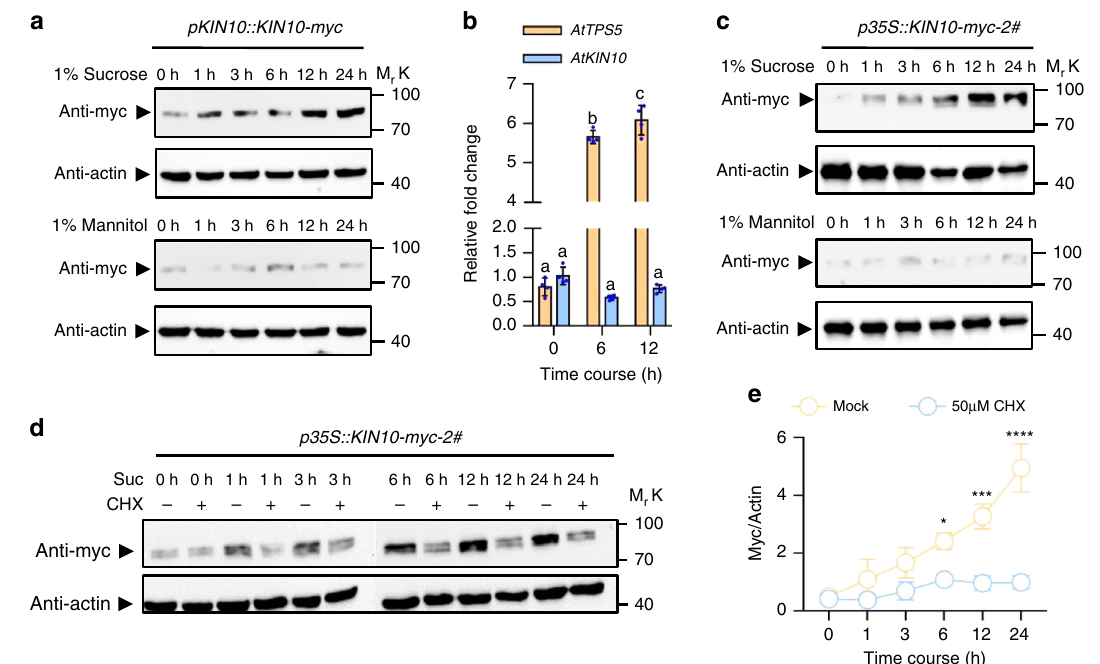
Fig. 3 Sucrose induces the KIN10 protein accumulation. a Immunoblot analysis of the protein levels of KIN10-myc in pKIN10::KIN10-myc transgenic plants using anti-myc antibody. Seedlings of pKIN10::KIN10-myc transgenic plants were grown in sugar free ½ MS liquid medium for 3 days and then treated with 1% sucrose or 1% mannitol for different time periods. b Quantitative RT-PCR analysis the expression of KIN10 in response to sucrose. Wild-type seedlings were grown in sugar free 1/2 MS liquid medium for 3 days then treated with 1% sucrose for different times. PP2A gene was analyzed as an internal control. Error bars represent standard deviation of four independent experiments. Different letters above the bars indicated statistically signi fi cant differences between the samples (ANOVA analysis followed by Uncorrected Fisher ’ s LSD multiple comparisons test, p < 0.05). c Sucrose induces KIN10 protein accumulation in p35S::KIN10-myc transgenic plants. Seedlings of p35S::KIN10-myc transgenic plants were grown in sugar free ½ MS liquid medium for 3 days and then treated with 1% sucrose or 1% mannitol for different time periods. d Immunoblot analysis the effects of cycloheximide (CHX) on the Sucrose-induced the KIN10 protein accumulation. Seedlings of p35S::KIN10-myc transgenic plants were grown in sugar free ½ MS liquid medium for 3 days and then treated with or without 1% sucrose and 50 μ M CHX for different time periods. e Quanti fi cation analysis of CHX effect on sucrose-induced KIN10 protein accumulation. The ratio of immunoprecipitated KIN10-myc to actin was quanti fi ed by ImageJ software. Values for different time points after sucrose addition with or without CHX treatment are given as mean ± S.E. ( n = 3). Asterisk above dots indicates signi fi cant inhibition of KIN10 protein accumulation by CHX treatment at different time points (ANOVA analysis followed by Uncorrected Fisher ’ s LSD multiple comparisons test, *p < 0.05; ** p < 0.01; **** p <